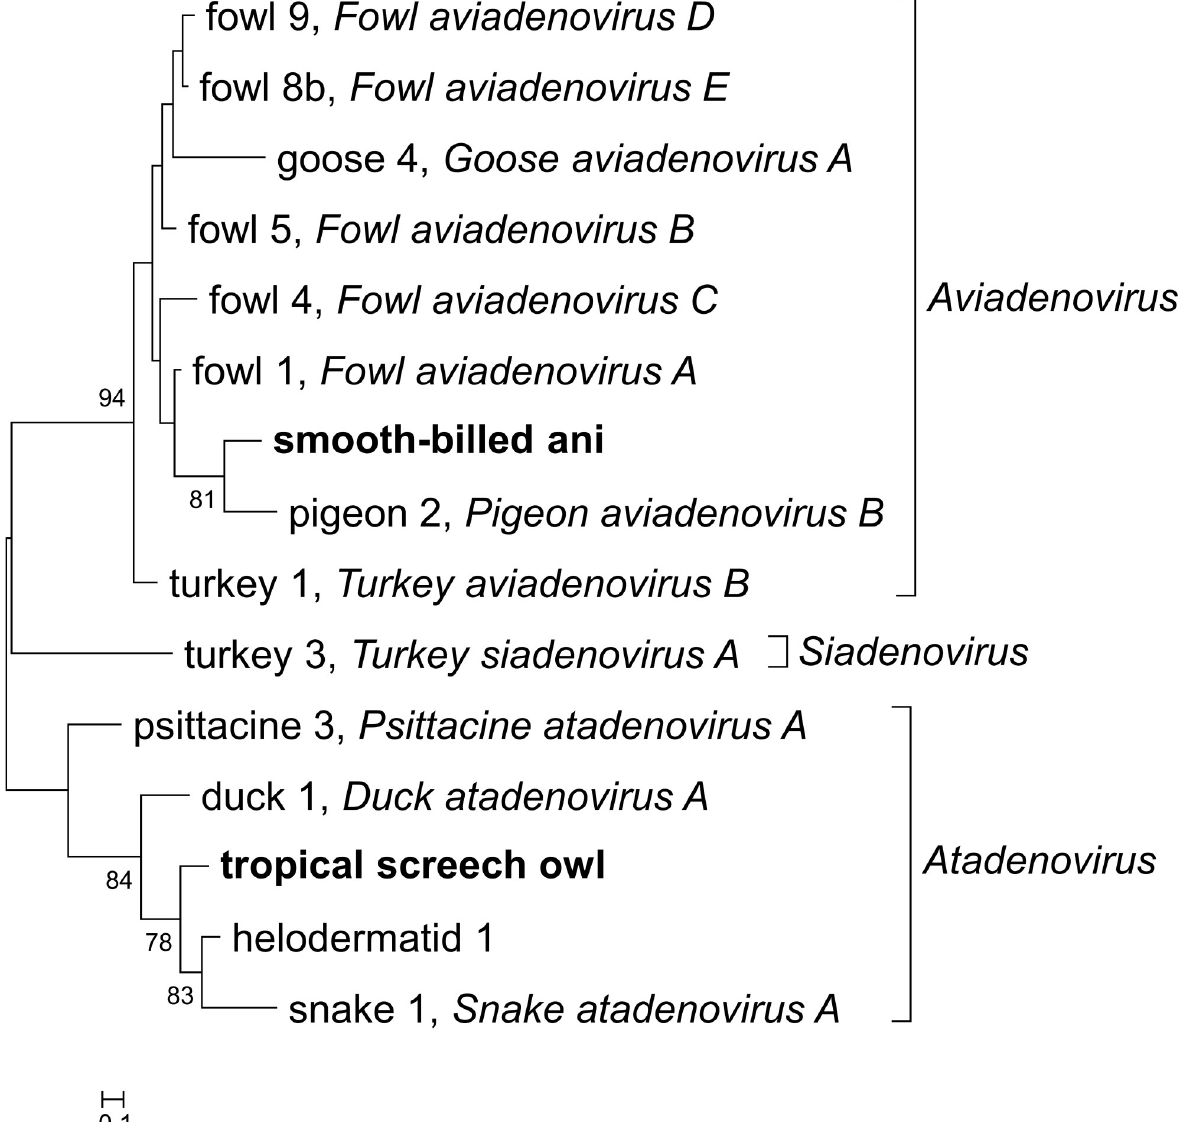
Fig 1. Phylogenetic analysis of the smooth-billed ani and the tropical screech owl adenoviruses. The tree is based on derived amino acid sequence of partial DNA polymerase gene sequences. Adenovirus strains are represented using the host name and the serotype ordinal number, and viral species names are also applied if available. The tree was rooted on the midpoint. Accession numbers: duck 1: NP_044702, fowl 1: AAC54904, fowl 4: AEK64762, fowl 5: YP_007985646, fowl 8b: ANJ02558, fowl 9: derived from AC_000013, goose 4: YP_006383556, helodermatid 1: AAS89696, pigeon 2: APO40944, psittacine 3: YP_009112716, smooth-billed ani: QHA24662, snake 1: YP_001552247, tropical screech owl: QHA24661, turkey 1: YP_003933581, turkey 3: